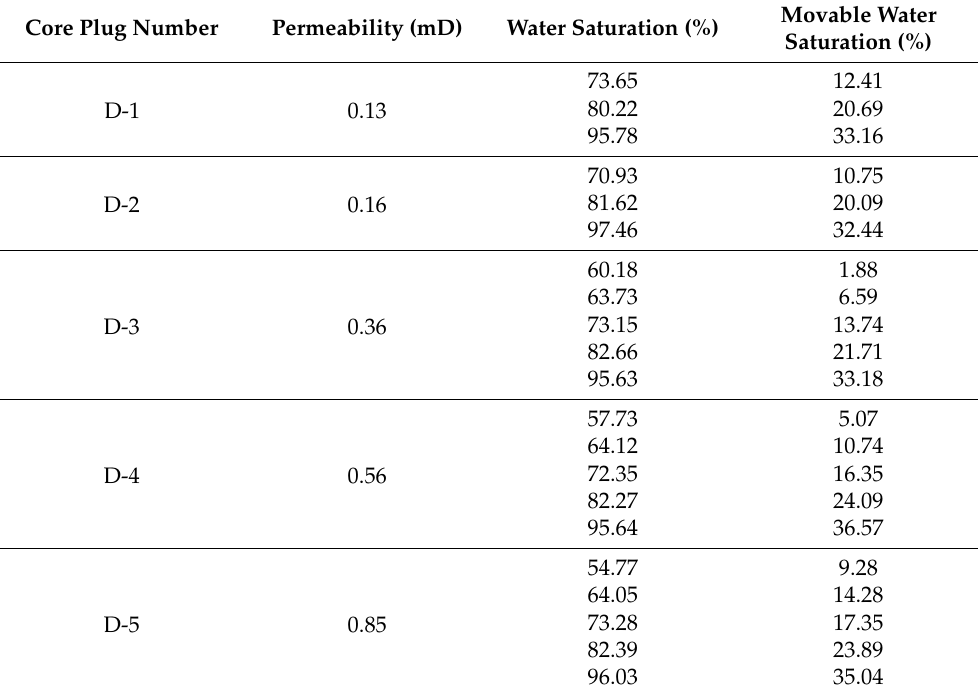
Table 4. The water saturation and the movable water saturation of core plugs.